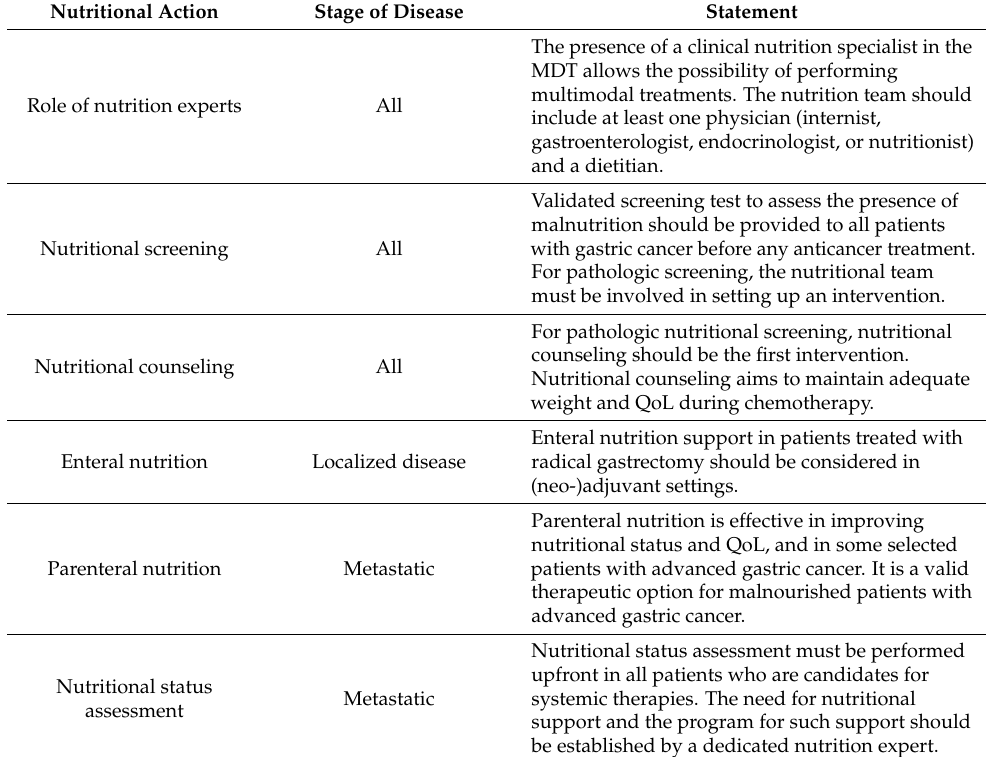
Table 3. Nutritional support: how and